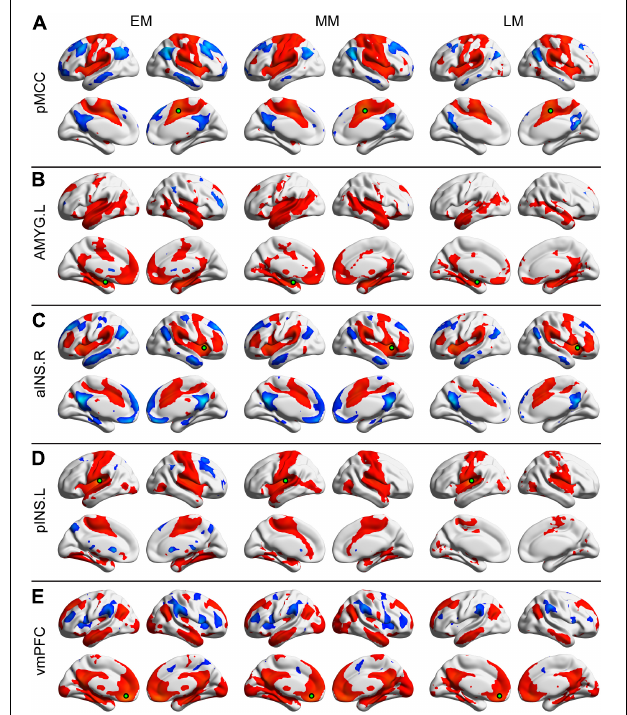
FIGURE 2 | Positive and negative functional connectivity maps seeded from the posterior midcingulate cortex (pMCC) (A) , the left amygdala (AMYG) (B) , the right anterior insula (aINS) (C) , the left posterior insula (pINS) (D) , and the ventromedial prefrontal cortex (vmPFC) (E) for the early- (EM, left column), middle- (MM, middle column), and late-adulthood males (LM, right column) (the seed was a 6 mm radius sphere shown in green; red and blue color indicated positive and negative connectivity maps, respectively, with a permutation test correction threshold of p < 0.05).